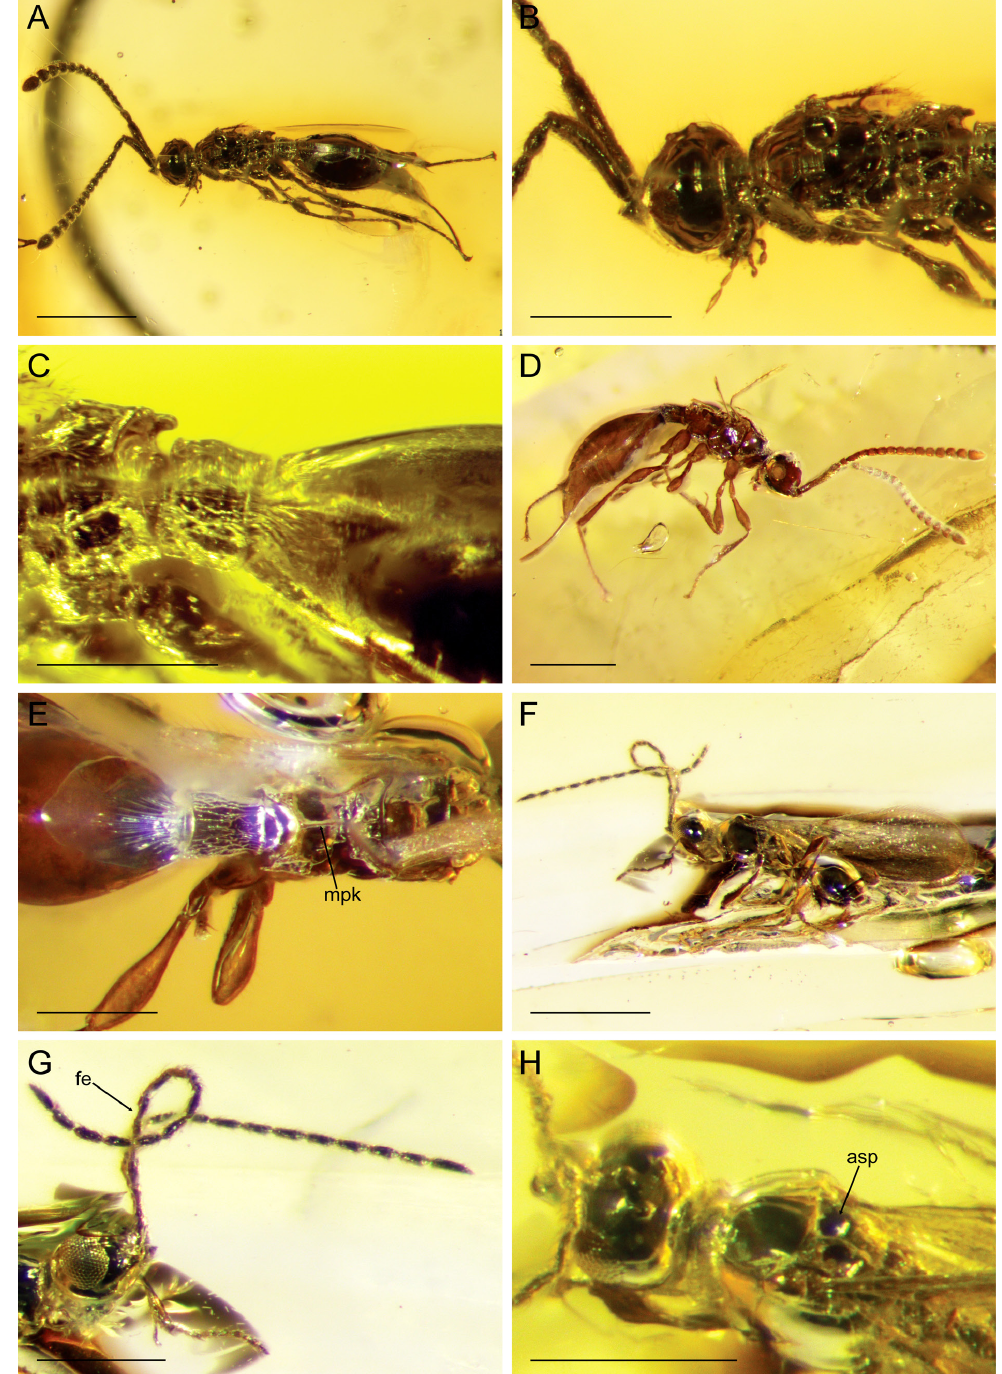
Fig. 5. A–C . Pantolyta chemyrevae sp. nov., holotype (NHMD-608448). A . Habitus in dorsolateral view. B . Head and mesosoma in dorsal view. C . Petiole in lateral view. D–E . Pantolyta similis sp. nov., holotype (NHMD-608468). D . Habitus in lateral view. E . Mesosoma, petiole and anterior gaster in dorsal view. F–H . Basalys villumi sp. nov., holotype (NHMD-608360). F . Habitus in lateral view. G . Head in lateral view. H . Head and mesosoma in dorsal view. Abbreviations: asp = anterior scutellar pit; fe = flagellomere emargination; mpk = median propodeal keel. Scale bars: A, D, F = 1 mm; B, E, G–H = 0.5 mm; C = 0.25